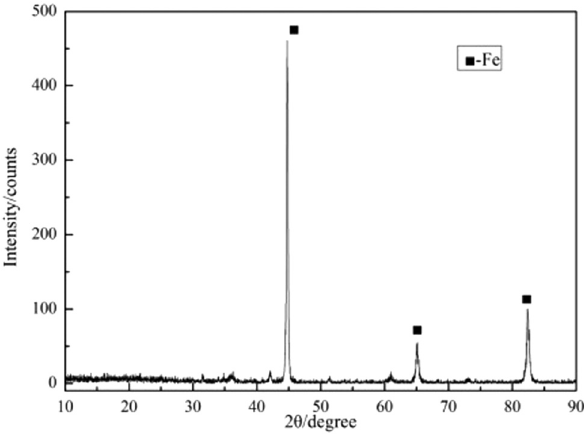
Figure 13: XRD pattern of roasting briquettes at the third